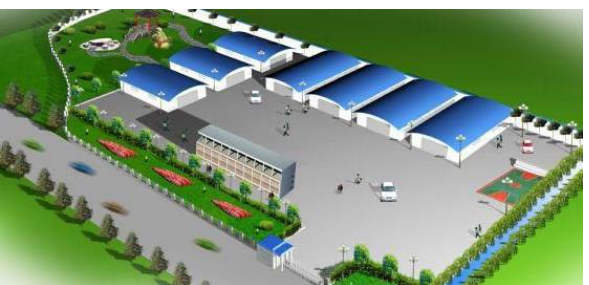
Figure 3. Logistics Centre Scene